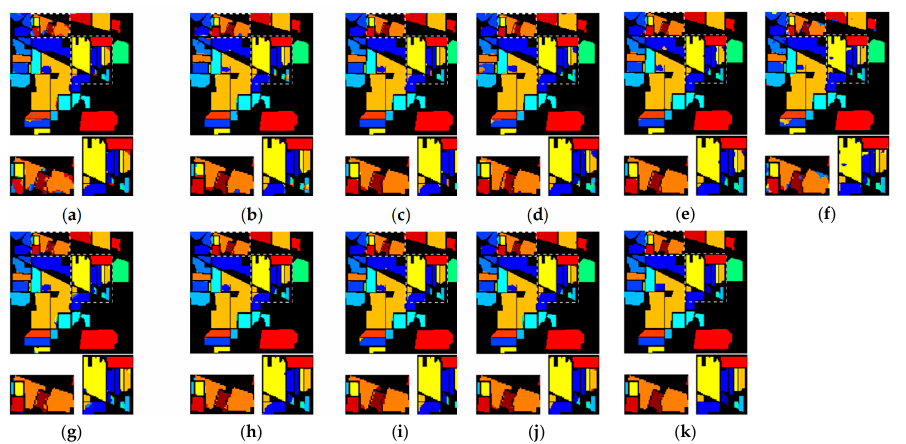
Figure 8. Classification maps generated by HybridSN using different BS methods for the